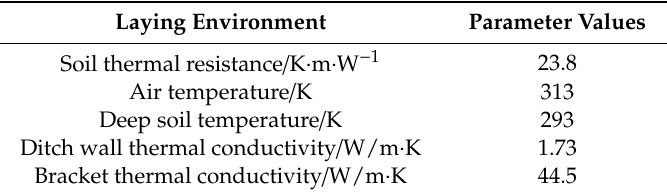
Table 2. Environmental parameters of cable trench.